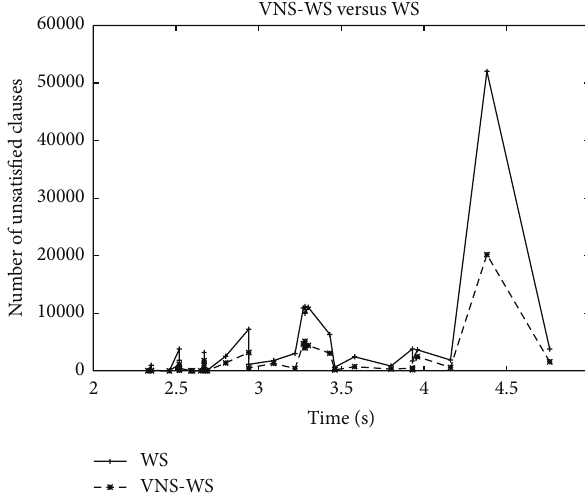
Figure 5: Convergence speed.